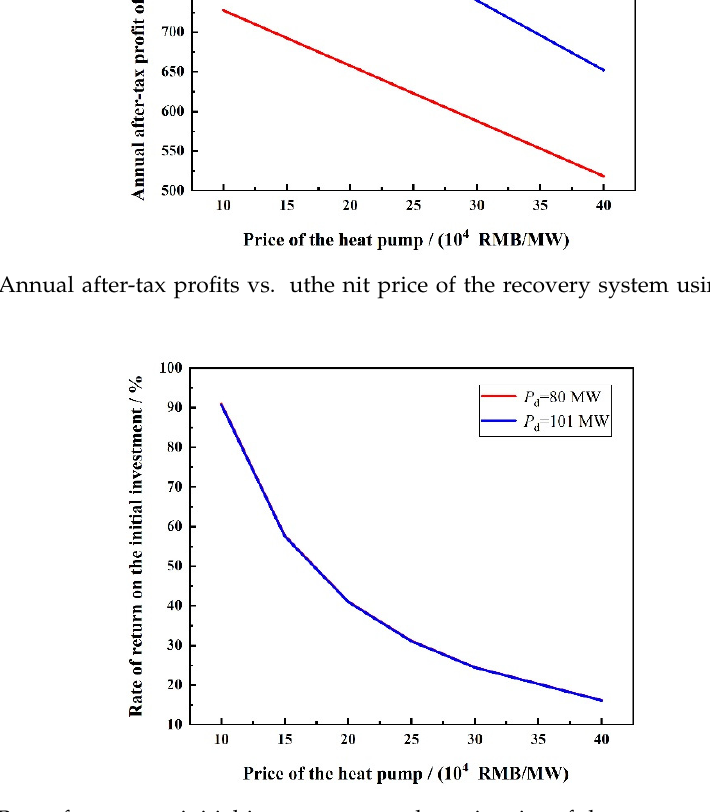
Figure 11. Rate of return on initial investment vs. the unit price of the recovery system using an absorption heat pump.